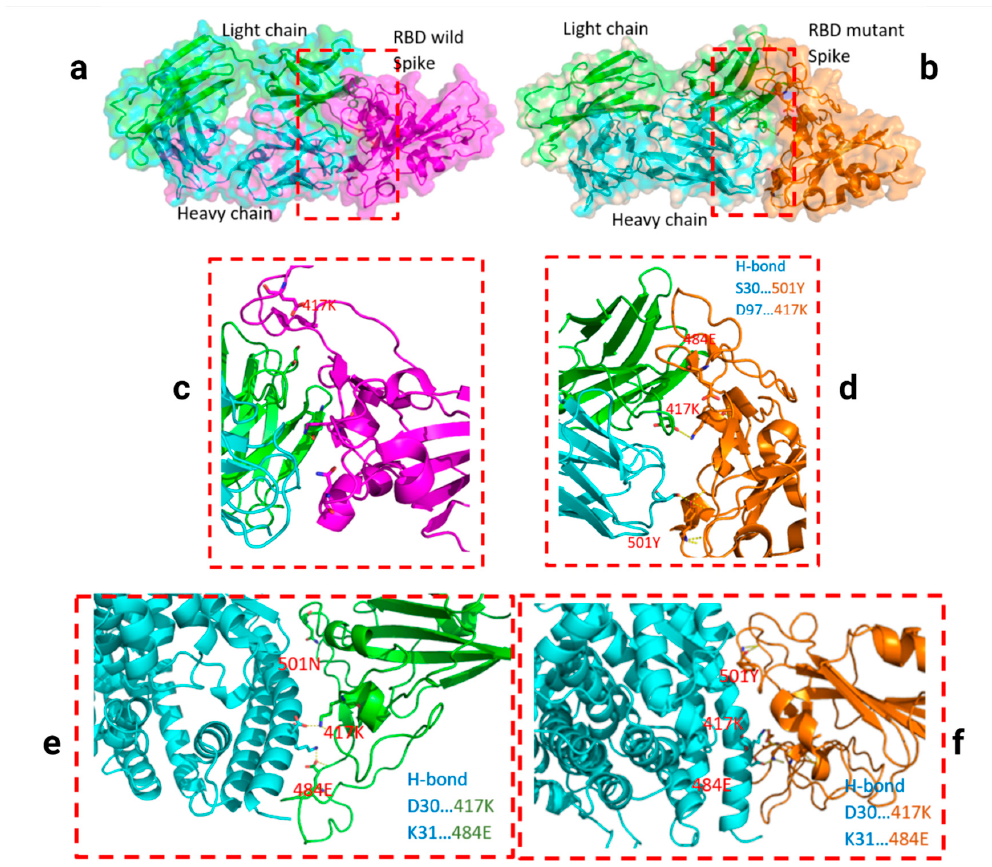
Figure 4. Docking structures of the interaction of SARS-CoV-2 S-RBD protein in complex with a potent neutralizing CV30 antibody. The structure of interactions of wild S-RBD protein with neu- tralizing CV30 antibody ( a , c ). Docking structure of interactions of mutant B.1.1.7 S-RBD protein with neutralizing CV30 antibody ( b , d ). The structure of interactions of wild S-RBD protein with human hACE2 ( e ). The structure of interactions of mutant B.1.1.7 S-RBD (N501Y) protein with human hACE2 ( f ). The dashed line indicates the hydrogen bond.